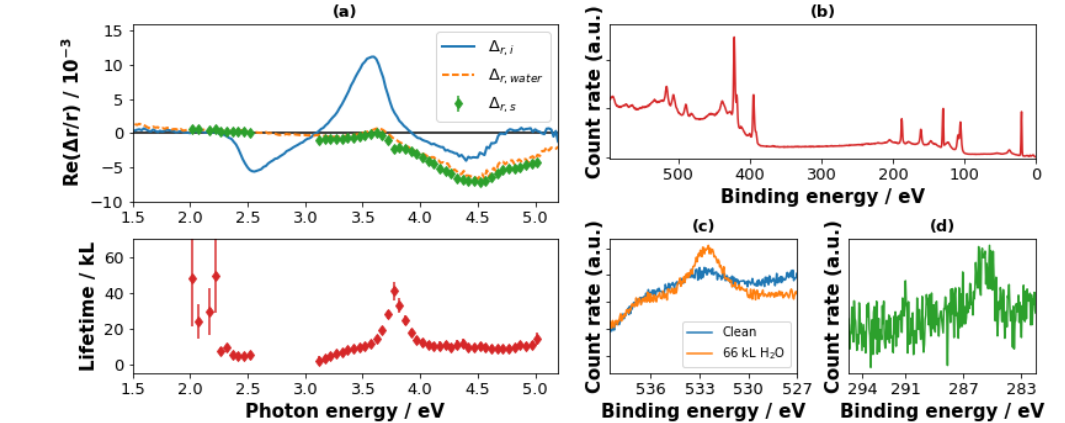
Figure 6: (a) RA spectrum of homoepitaxial, P-rich GaP(100) before (blue) and after (orange, dashed) the 66 kL H O, together with the saturation values from the fits 2 (green). The lower part of the plot shows the corresponding lifetimes. (b) XPS Al K α excitation (normal emission) overview spectrum. (c) XPS (60 ◦ take-off angle) around the O 1s line before (blue) and after (orange) water exposure. (d) C 1s (60 ◦ ) after water